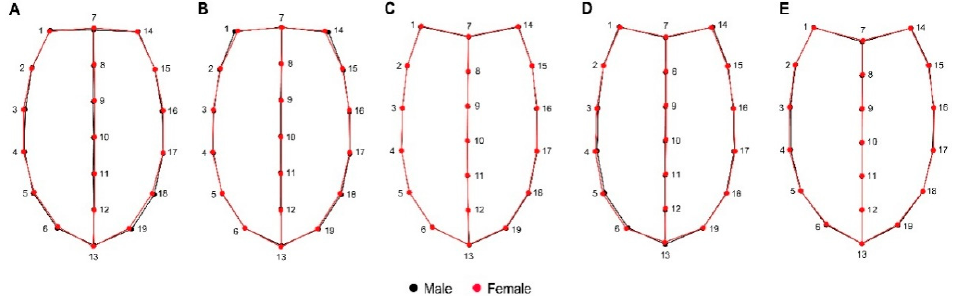
Figure 8. Wireframe representation of the superimposition between the average elytral shape between male and females, and their corresponding landmarks in all the analyzed species in this study. ( A ): Carabus exaratus, ( B ): Carabus granulatus, ( C ): Pterostichus melanarius, ( D ): Pterostichus niger, and ( E ): Pterostichus oblongopunctatus.